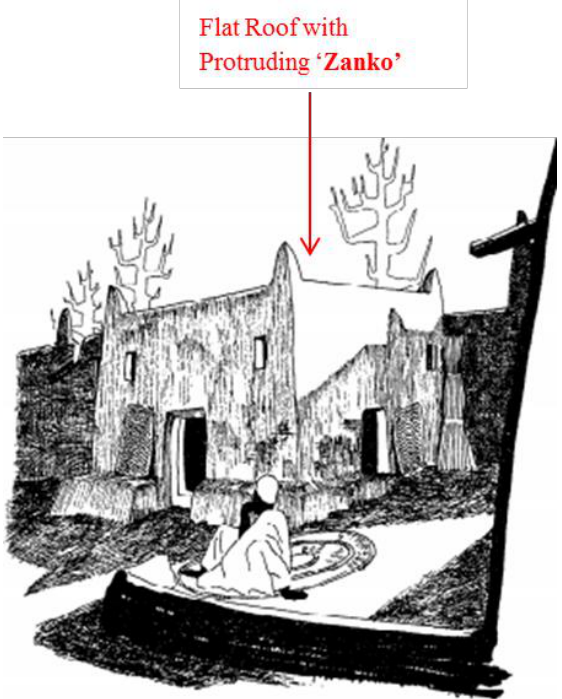
Figure 5. Outdoor Space for Relaxation (Moughtin,